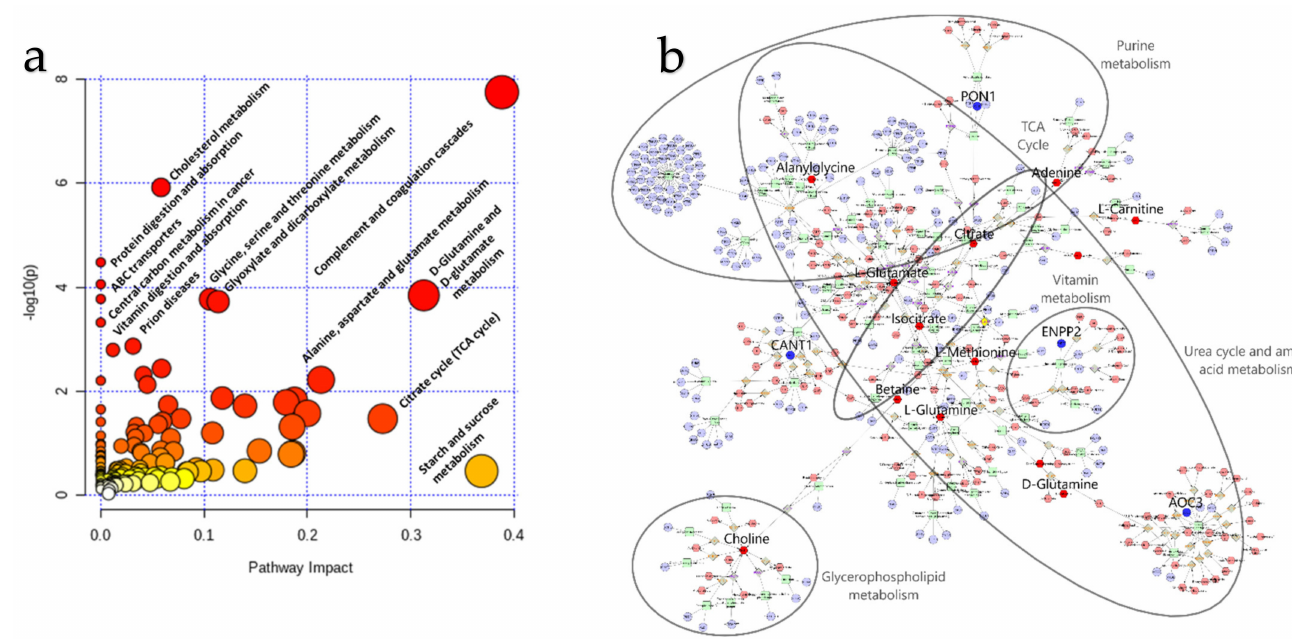
Figure 6. ( a ) Joint pathway enrichment analysis performed in MetaboAnalyst reveals the key pathways in cerebrospinal fluid affected by intervertebral disc herniation (IVDH) in dogs. ( b ) Pathway-based Compound-Reaction-Enzyme-Gene (C-R-E-G) network obtained using significantly deregulated genes and metabolites visualized in Cytoscape plugin Metscape (nods: blue—gene, red—compound/metabolite, green—enzyme). Highlighted blue (gene) and red (metabolite) nods represent input data. Enlarged feature names, together with the metabolic pathways, represent the features closely related to the IVDH. The C-R-E-G network is also available as a Supplementary File for better insight into various features (Supplementary Figure